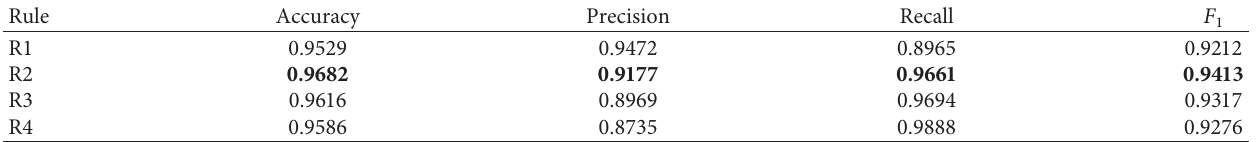
Table 16: Performance comparison of different rules on logistic regression.